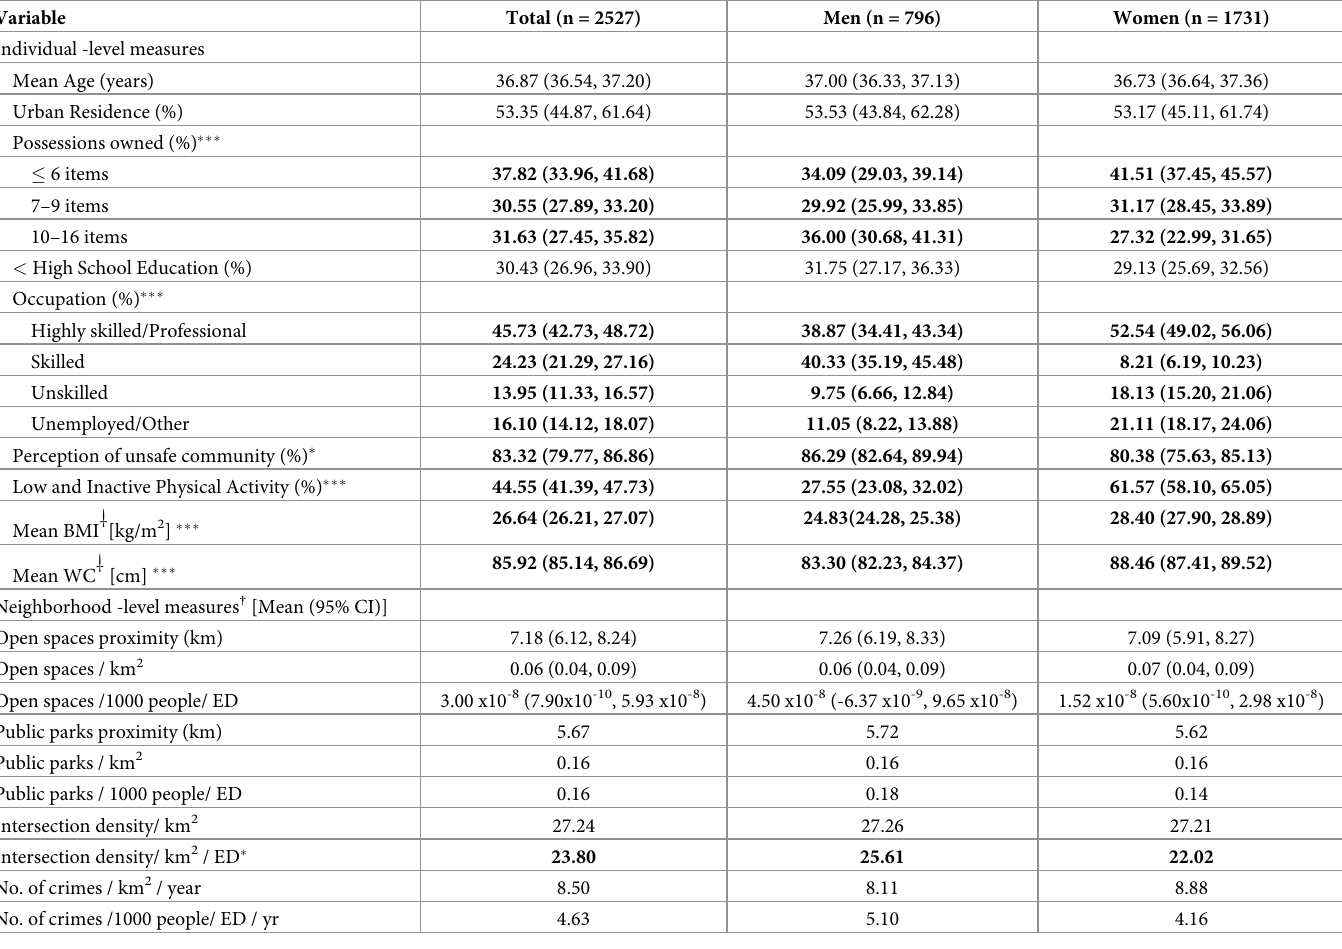
Table 1. Total and sex-specific weighted sample characteristics (95% CI) for Jamaicans (JHLS II, 2008).